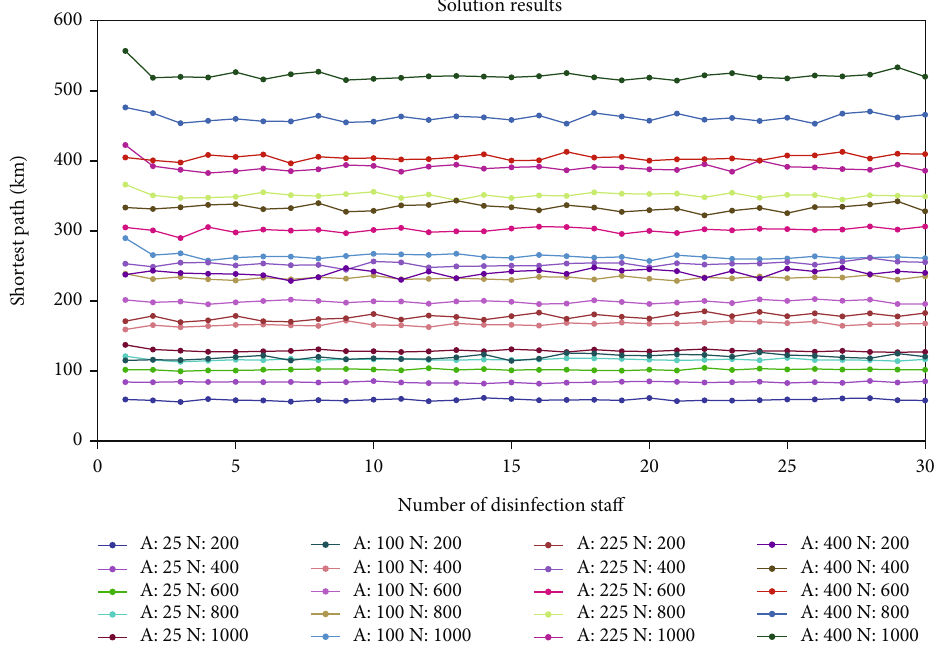
Figure 5: Experiment